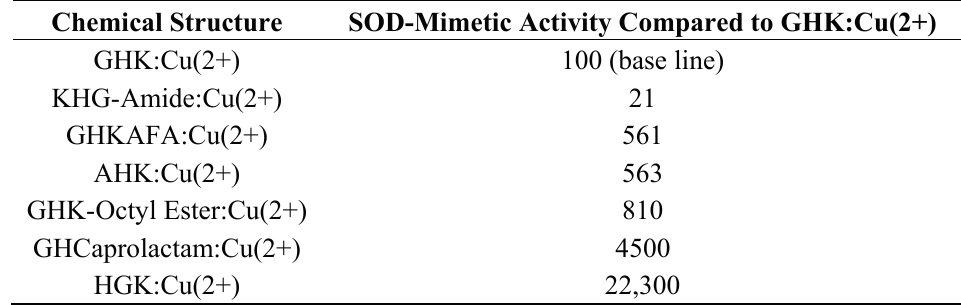
Table 1. SOD-mimetic activity of GHK-Cu chemical analogs.